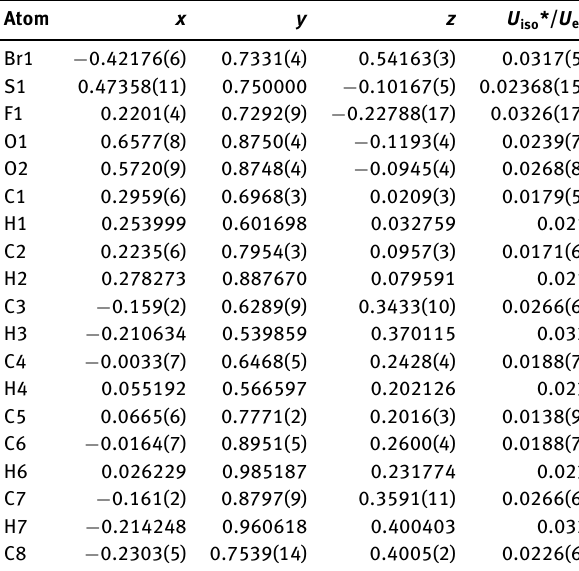
Table 2: Fractional atomic coordinates and isotropic or equivalent isotropic displacement parameters (Å 2